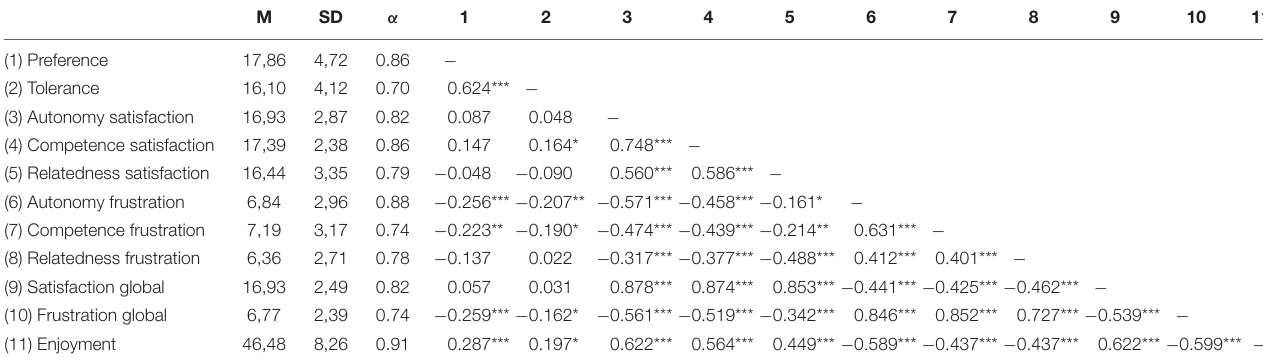
TABLE 1 | Descriptive statistics and correlation analysis of exercise intensity-traits, basic psychological needs, and enjoyment. M SD α